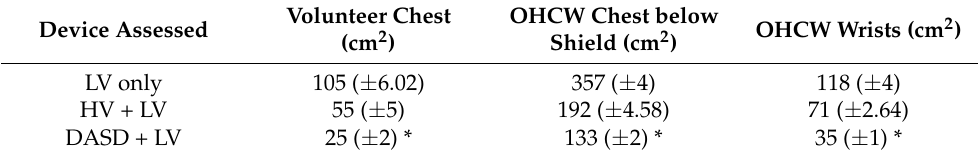
Table 1. Collection of aerosol and splatter on different areas of the OHCW and volunteer. Device